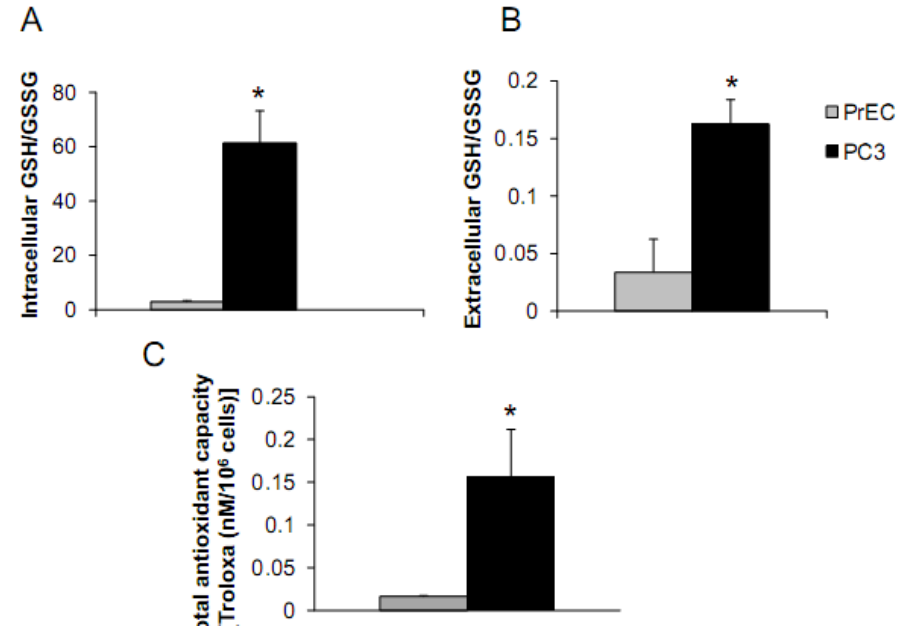
Figure 1. Analysis of redox state in PrEC vs . PC3 cells. PrEC or PC3 cells were cultured in prostate epithelial growth medium (PrEGM) or RPMI 1640 media for 24 h. Cells and conditioned media were collected for analysis. ( A ) Intracellular GSH/GSSG ratio; ( B ) Extracellular GSH/GSSG ratio; ( C ) Total antioxidant capacity. * P-value ≤